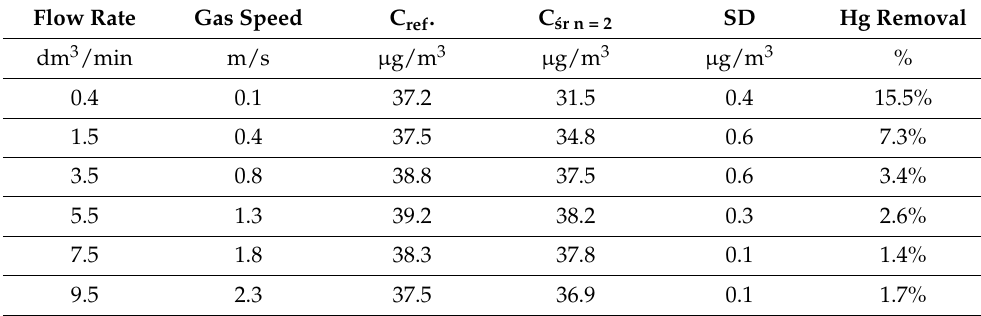
Table 3. The effect of gas velocity on mercury removal efficiency (SPC material).